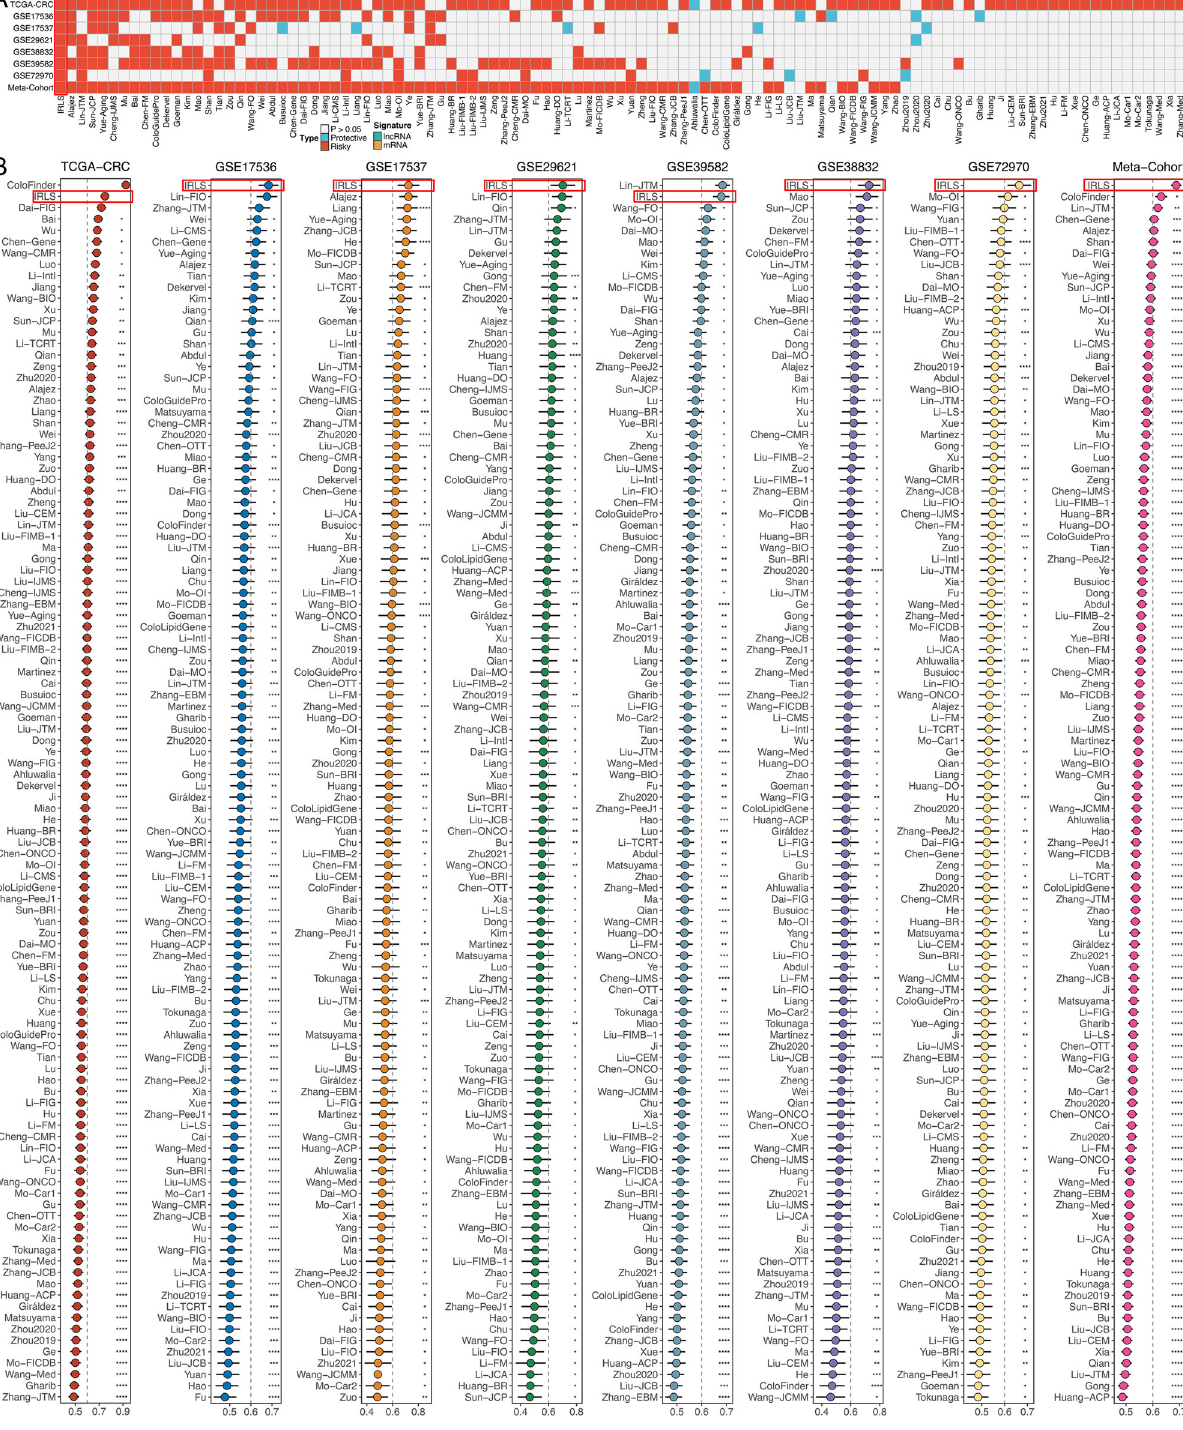
Fig. 4 Comparison of gene expression-based prognostic signatures in CRC. A Univariate Cox regression analysis of IRLS and 109 published signatures in TCGA-CRC, GSE17536, GSE17537, GSE29621, GSE38832, GSE39582, GSE72970, and meta-cohort. B C-index analysis IRLS and 109 published signatures in TCGA-CRC ( n = 584), GSE17536 ( n = 177), GSE17537 ( n = 55), GSE29621 ( n = 65), GSE38832 ( n = 122), GSE39582 ( n = 573), GSE72970 ( n = 124), and meta-cohort ( n = 1700). Statistic tests: two-sided z-score test. Data are presented as mean ± 95% con fi dence interval [CI]. * P < 0.05; ** P < 0.01; *** P < 0.001; **** P < 0.0001.